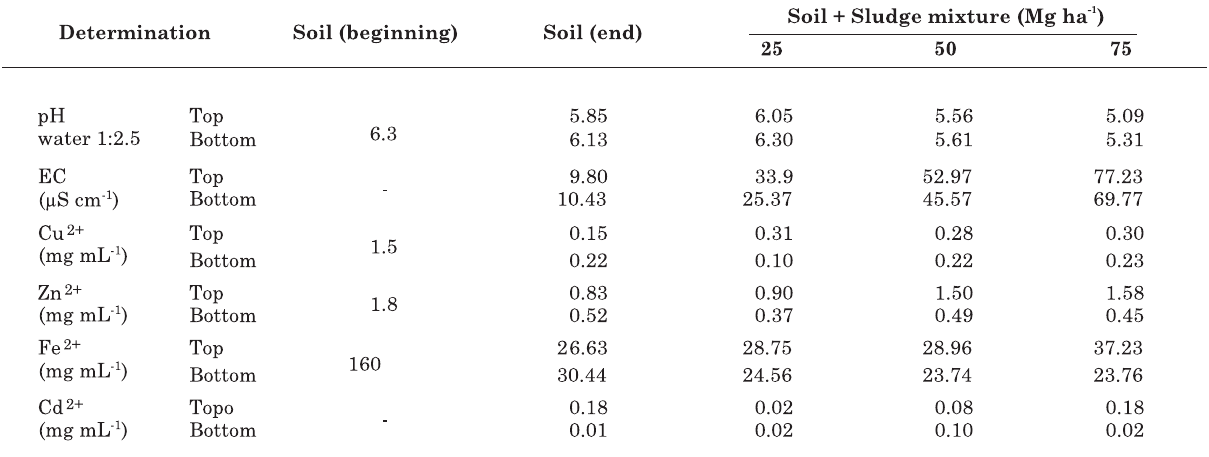
Table 3. Values of pH, electrical conductivity (EC), Cu 2+ , Zn 2+ , Fe 2+ , and Cd 2+ at the top and bottom of columns of soil and